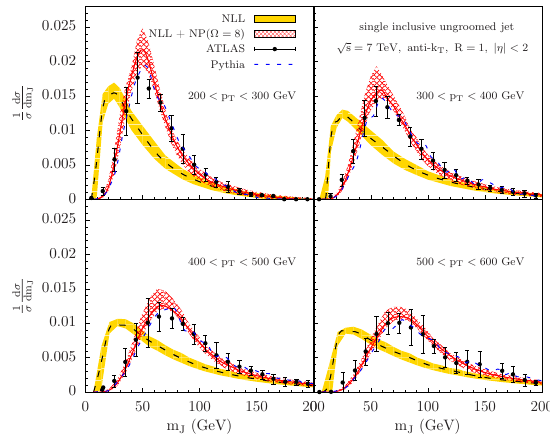
drop groomed jet substructure observables have also received an increasing attention from both ex- periment and theory. Jet grooming techniques can be used to isolate di ff erent aspects of jet quenching Figure 2. Comparison with the experimental data from the ATLAS collaboration [20] taken at √ s = 7 TeV.